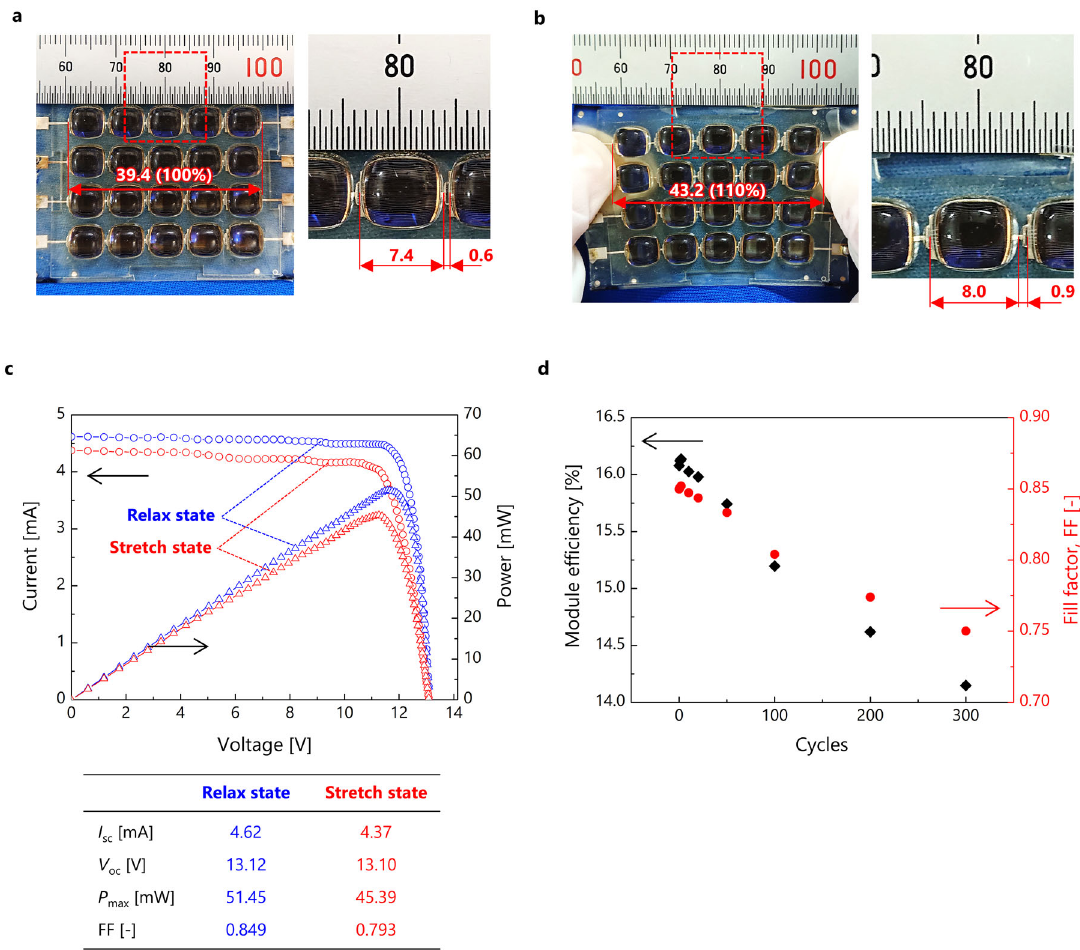
Fig. 2 Power-generation characteristics under stretch state. Photographs of the prototype module under ( a ) relax and ( b ) maximum stretch (10% strain) states (Unit: mm). The right-side photographs are magni fi cations of the region marked by red-colored rectangle in the left-side photographs. c Current – voltage ( I – V ) and power – voltage ( P – V ) characteristics under relax and maximum stretch states. I sc , V oc , P max , and FF are short-circuit current, open-circuit voltage, generated power, and fi ll factor, respectively. d Cycling test showing the module conversion ef fi ciency and FF when stretched by 10% up to 300 cycles. The I – V and P – V characteristics were measured for uppermost string in ( a ) and ( b ) at indoor 1 sun (1000 W m − 2 ) irradiation and room temperature (~25 °C). The module conversion ef fi ciency was calculated as the ratio of P max per active module area (one string: 8 mm × 8 mm × 5 lenses) to irradiance (1000 W m − 2